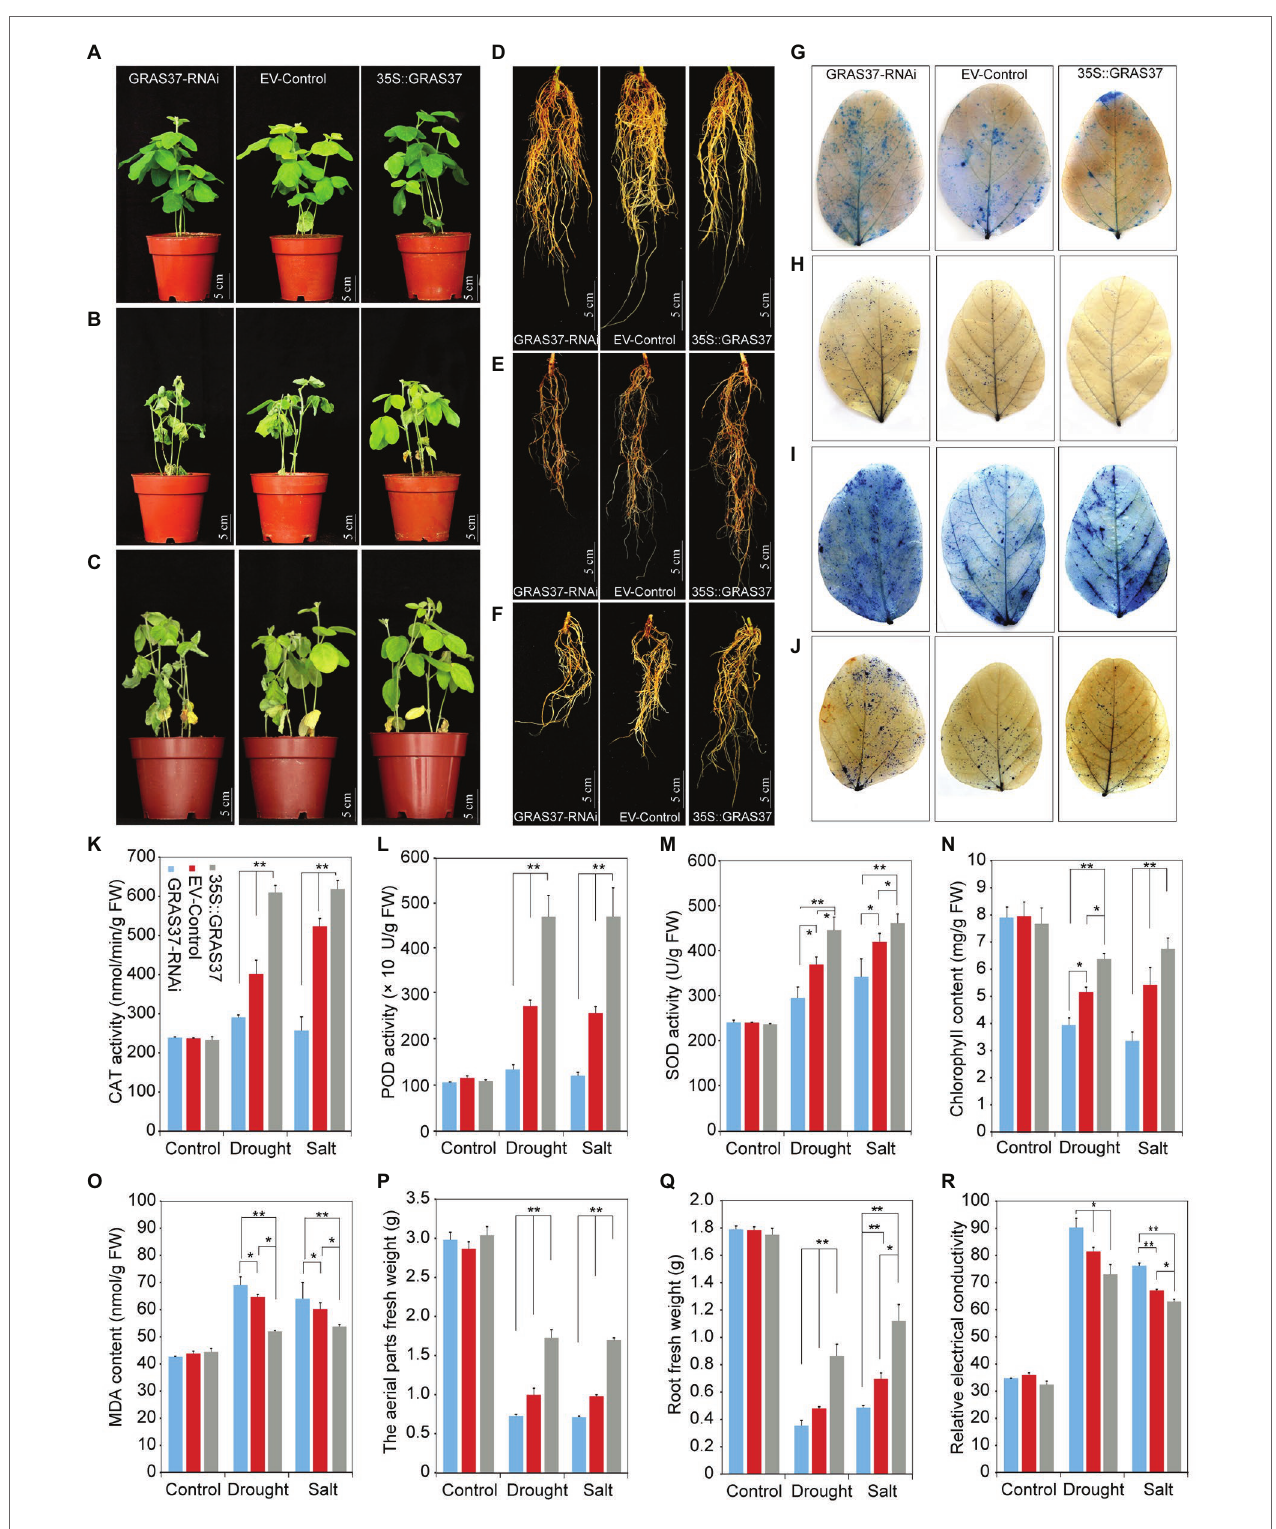
FIGURE 12 | Analysis of the function of soybean GmGRAS37 under normal conditions and drought and salt stresses. (A–C) Phenotypes of transgenic soybean hairy root composite GRAS37 -RNAi, EV-Control (expressing the pCAMBIA3301 empty vector), and GmGRAS37 -overexpression ( 35S::GRAS37 ) plants